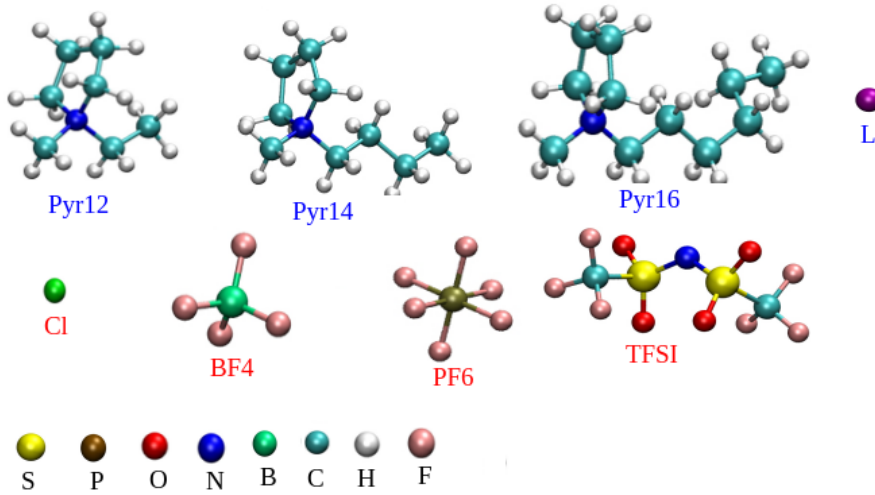
Figure 1. Top row: three of the pyrrolidinium cations (Pyr12, Pyr14, and Pyr16) and the Li-ion; bottom row: anions Cl, BF4, PF6, and